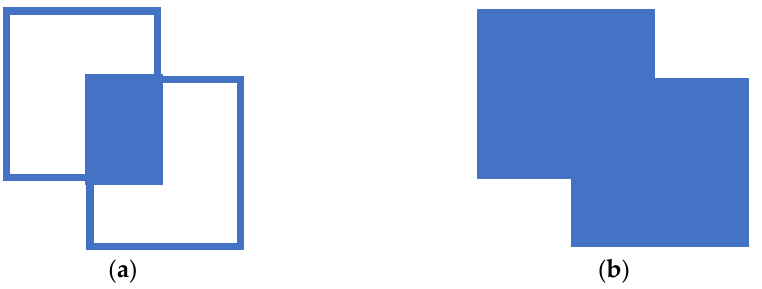
Figure A2. Examples of different types of bounding box areas; ( a ) intersection ( b ) union.